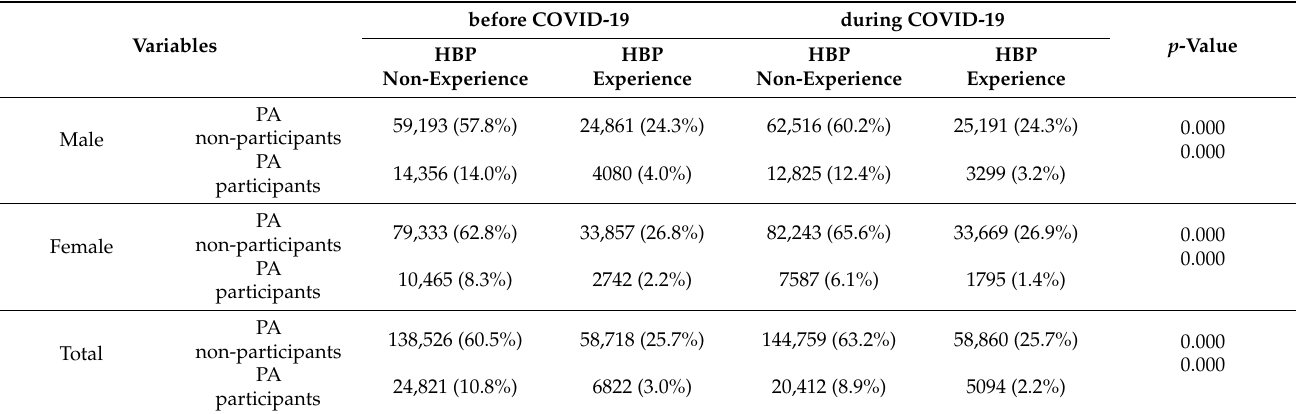
Table 4. Changes in HBP by gender and regular PA before and during